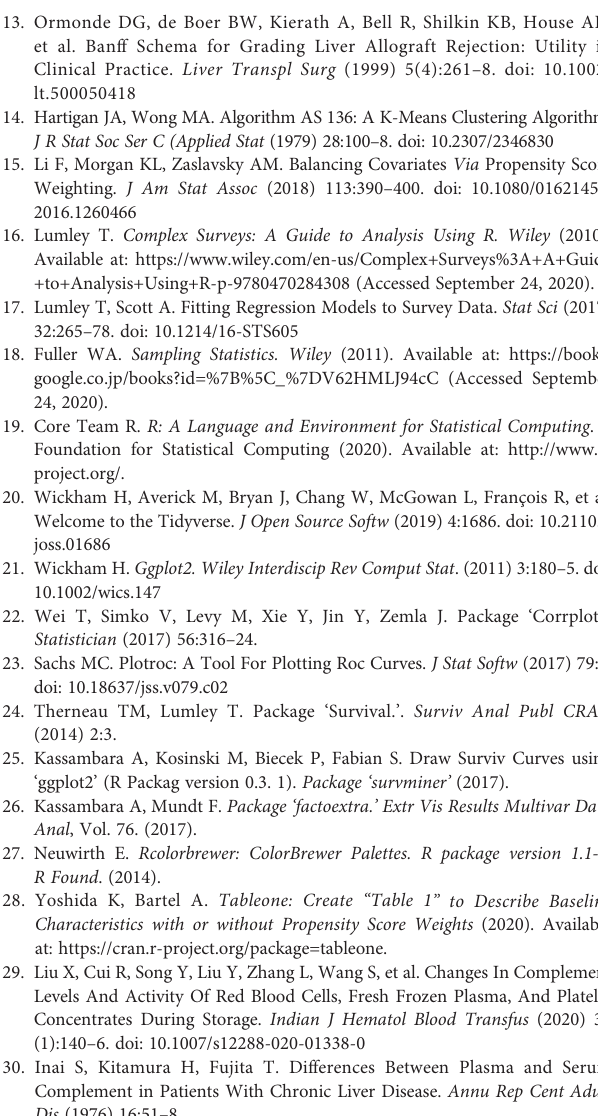
patients without cytomegalovirus(CMV) infection byday 90. Triangles: patients with CMV infection byday